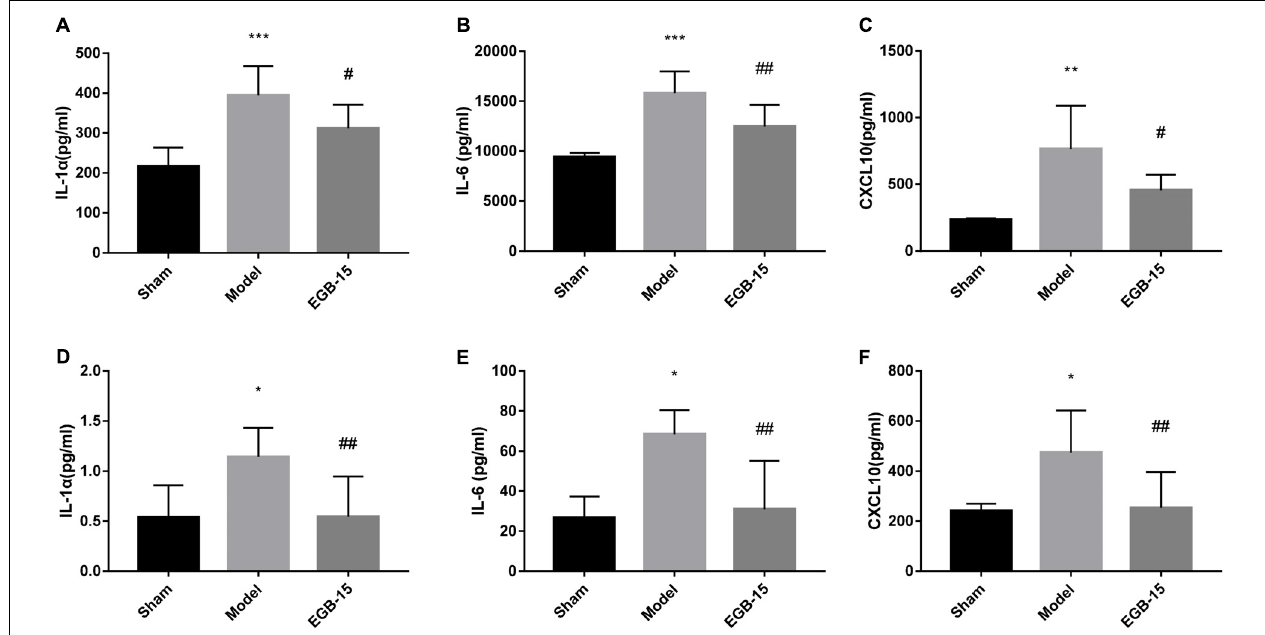
FIGURE 3 | Effects of EGB treatment on the level of cytokines/chemokines in the brain after cerebral ischemia. (A–F) Analysis showing the relative levels of the pro-inflammatory mediators IL-1 α , IL-6, and CXCL 10 (IP-10), (A–C) was in brain, (D–F) was in serum. Data are expressed as mean ± SEM ( n = 5). ∗ p < 0.05, ∗∗ p < 0.01 and ∗∗∗ p < 0.001 vs. sham group; # p < 0.05 and ## p < 0.01 vs. the model